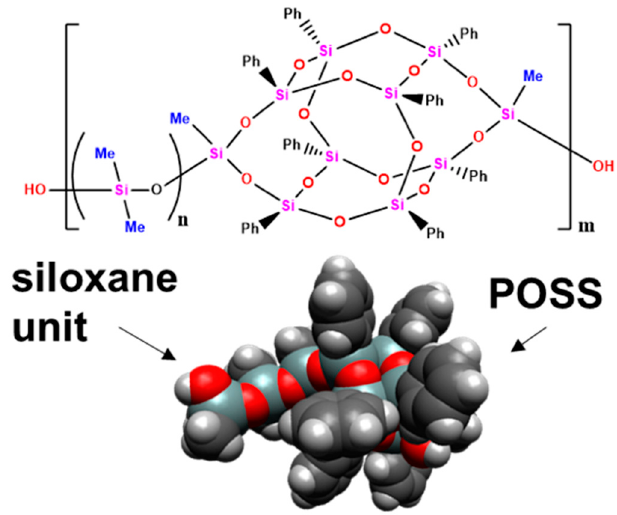
Figure 1. Chemical structure and 3D representation of the repeating unit in the DMS@POSS polymers.